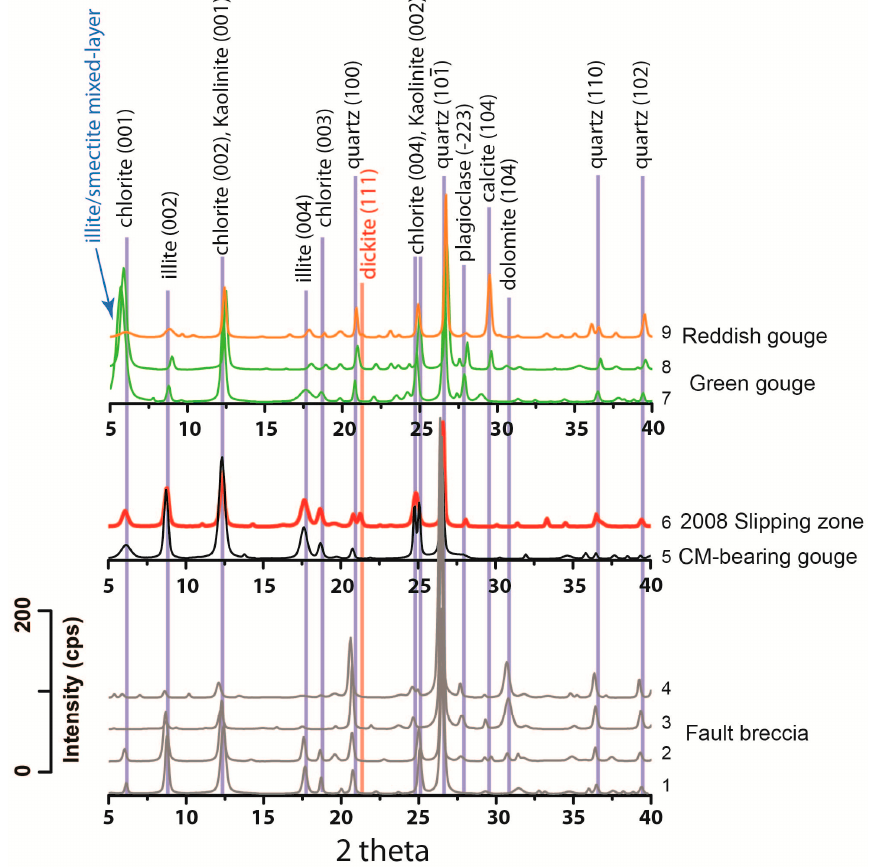
Figure 3. Characterization of the mineral phases of the Jiulong trench samples. The mineral phases of the breccia are very similar to those of the gouge zone. The X-ray diffraction (XRD) data of the carbonaceous material (CM)-bearing gouge demonstrate the presence of dickite (cps: counts per second).